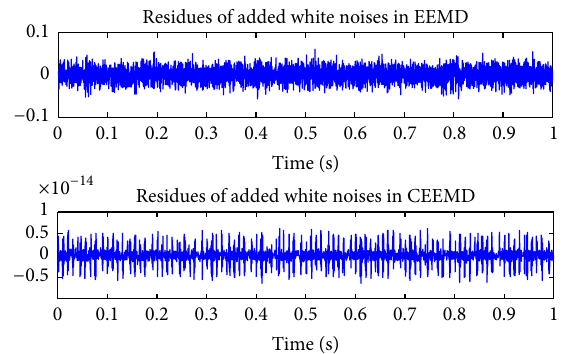
Figure 3: Residues of added white noises derived by EEMD and CEEMD.